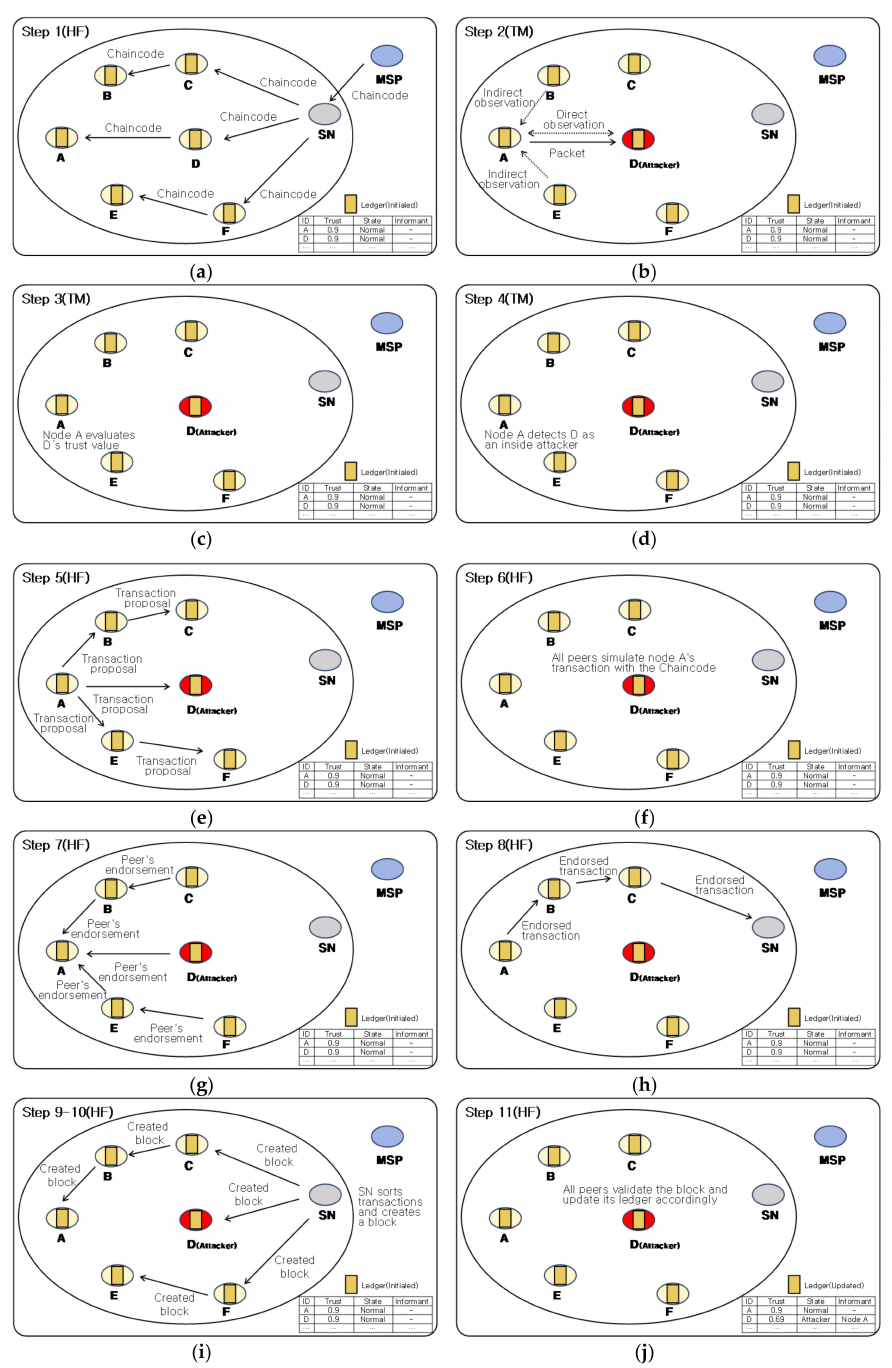
Figure 7. Description of working steps of the proposed model in a WSN; D is an inside attacker. ( a ) step 1; ( b ) step 2; ( c ) step 3; ( d ) step 4; ( e ) step 5; ( f ) step 6; ( g ) step 7; ( h ) step 8; ( i ) step 9–10; ( j ) step